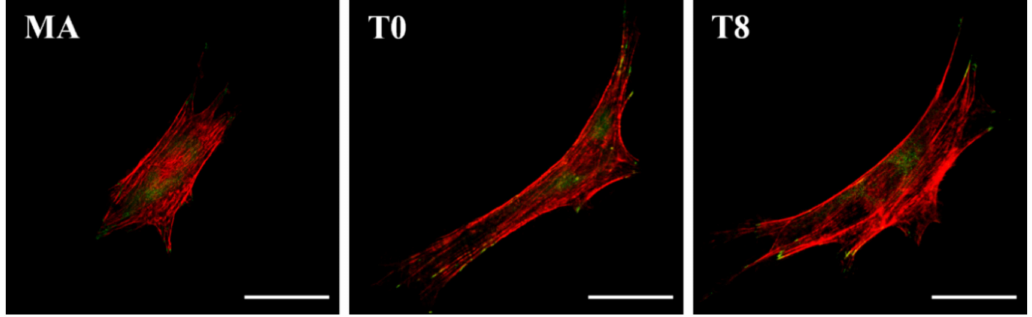
Figure 5. Fluorescence images of actin (red) and vinculin (green) in osteoblasts cultured on the specimens for 24 h (scale bar = 50 µ